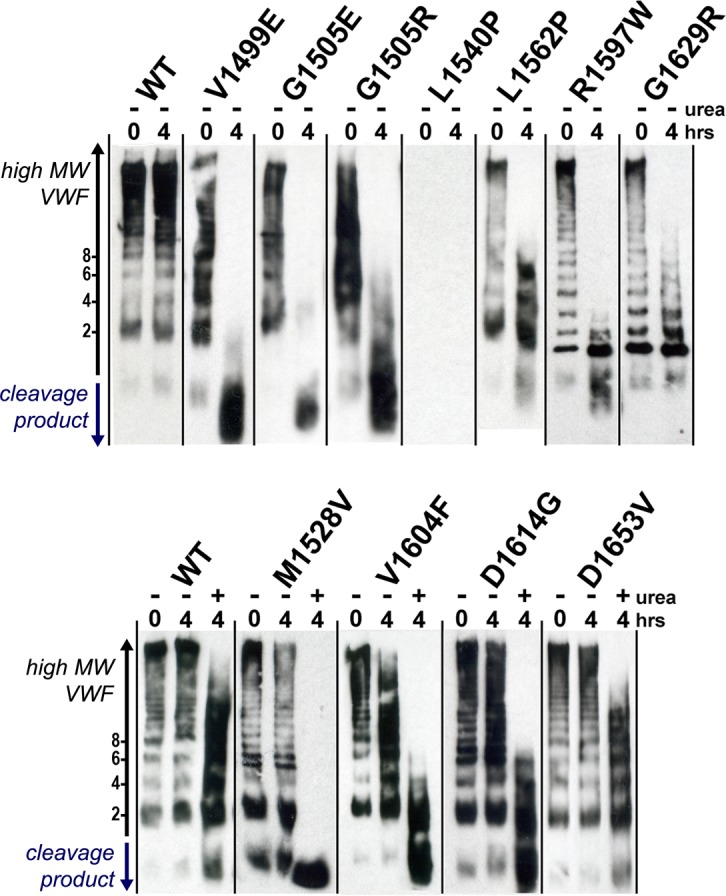
Multimer structure and ADAMTS13 proteolysis of FLVWF variants.The multimeric structures of recombinant FLVWF and its variants (500ng/ml) (with the exception of L1540P where no protein was expressed), were analysed before (0hrs) and after a four hour incubation with ADAMTS13 (10nM) (4hrs) in the presence (+) or absence (-) of 2M urea. The number of VWF monomers within a band and the direction of increasing multimeric size are indicated in black. Upon ADAMTS13 proteolysis, high MW VWF is lost, and cleavage products appear below the dimeric (2) band.